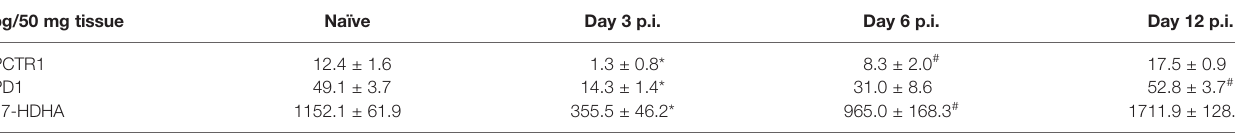
Mice were infected with 10 5 PFU of RSV and lung was obtained at the speci fi ed time points post infection (p.i.). Values are mean of n = 3-4 mice per time point ± SEM. *p < 0.01 vs naïve, # p < 0.01 vs day 3 post-infection by one-way ANOVA with Holm-Sidak ’ s multiple comparisons correction.